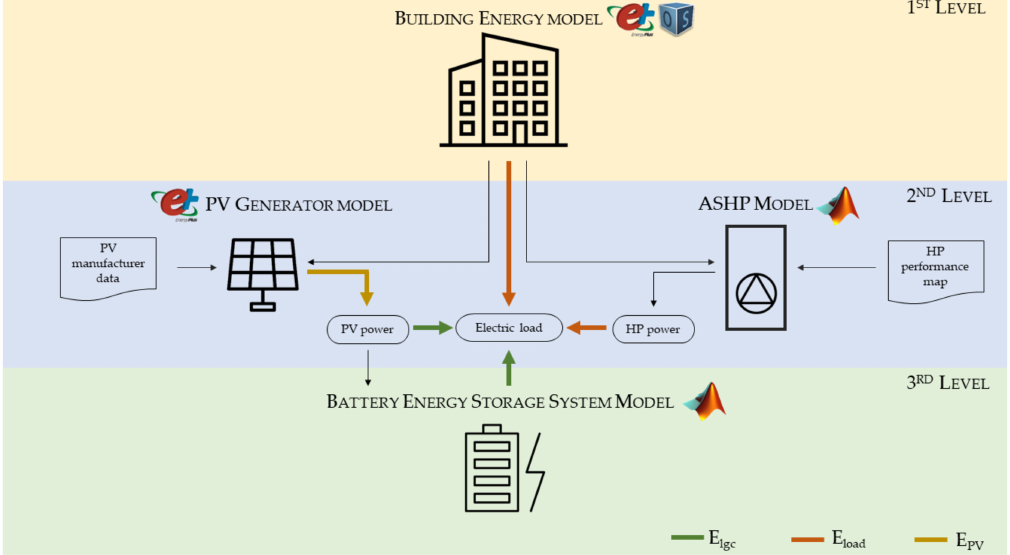
Figure 5. PVZEN facility modelling